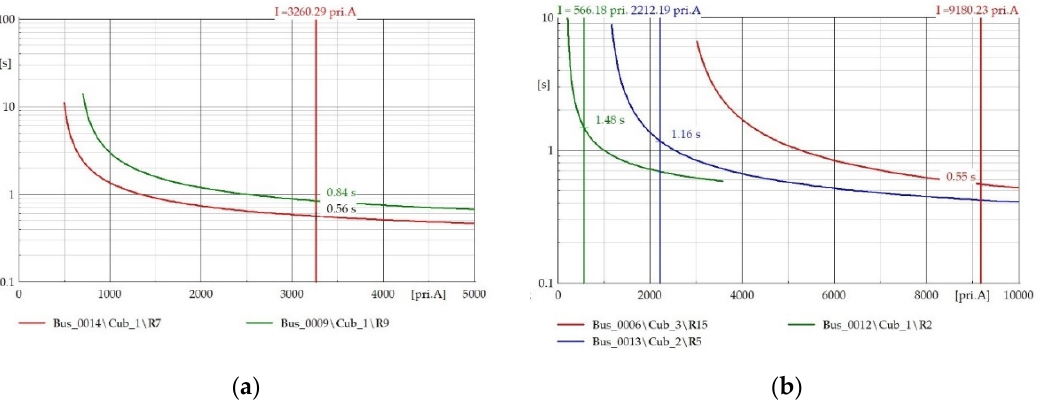
Figure 8. ( a ) T3, R7 (red) primary operation with backup R9 (green) obtained with cluster 2 settings; ( b ) T11, R15 (red) primary operation with backup R5 (blue) and R2 (green) obtained with cluster 2 settings.